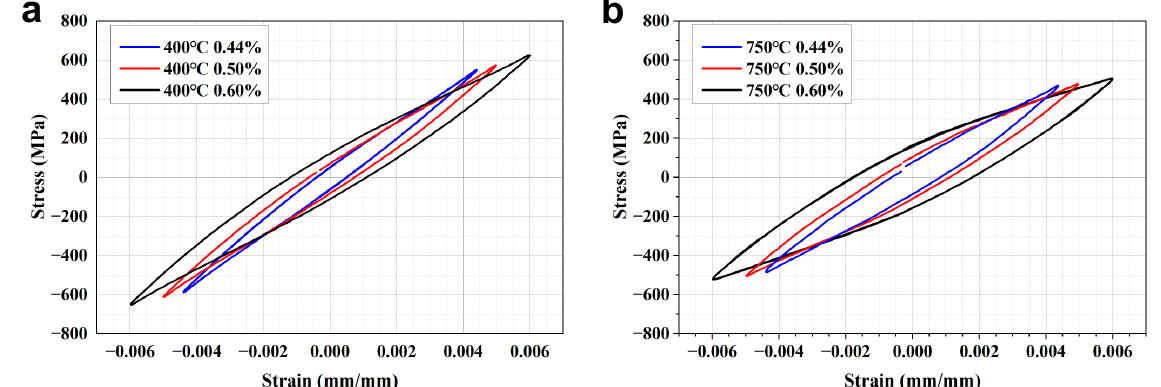
Figure 3. Stable stress-strain curves of the TiAl alloy at ( a ) 400 °C and ( b ) 750 °C.